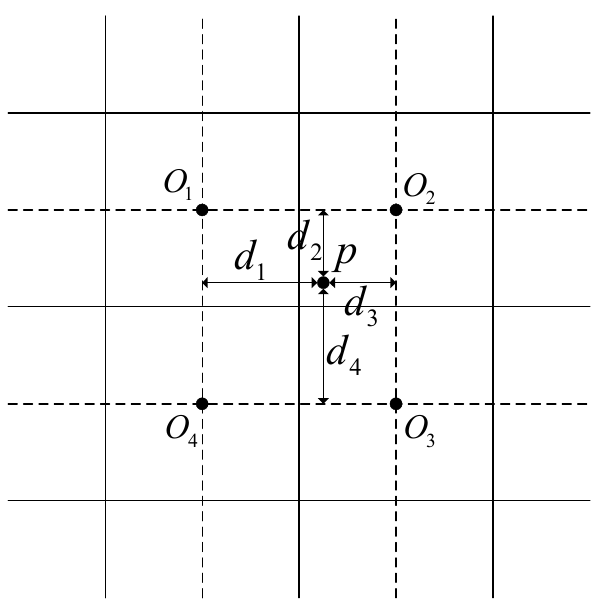
Figure 2. Diagram of the optimization problem.